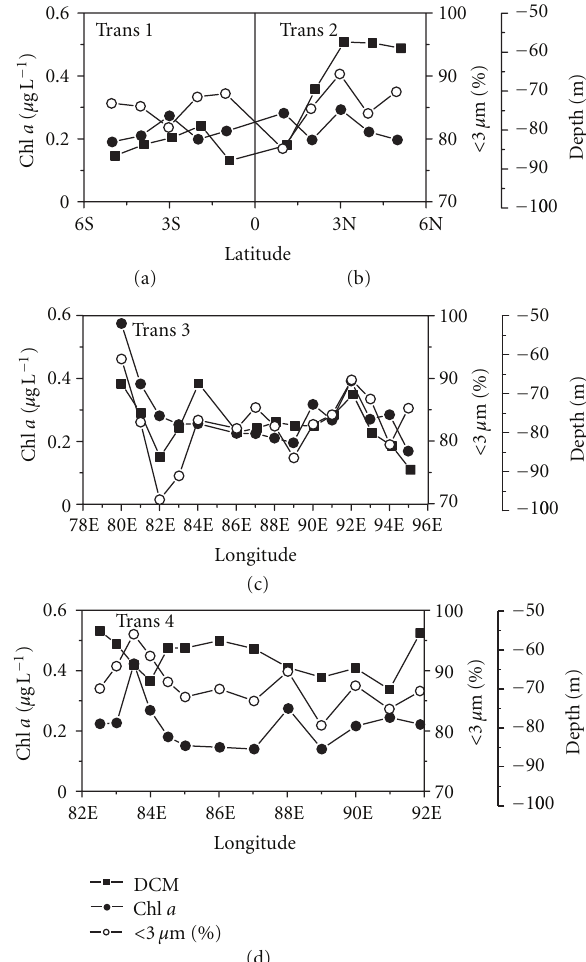
Figure 3: Variability of the Chl a concentration ( µ gL − 1 ), propor- tion of picocells fraction (%) and depth (m) of the DCM: in latitude ((a) and (b)) and longitude ((c) and (d)).